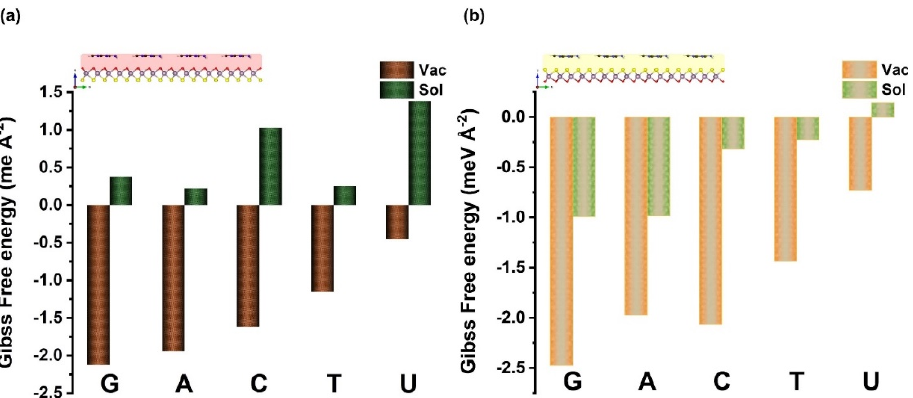
Figure 3. Gibbs free energy (T = 298 K) at vacuum (solvent) of the nucleobases molecules on the Janus MoOS monolayer facets, ( a ) on O layer, ( b ) on S layer, respectively. To understand the effect of the adsorption and sensing process, the Kohn–Shan Table 2. The deformation energy of DNA (RNA) molecules on the Janus MoOS of both oxygen (Oxy.) and sulfur (Sul.) layers, deformation energy of total system E Def–Tot , monolayer surface facets E Def–Lyr , nucleobases molecule E Def–Mol , and covalently energy E Def–Cov (All in eV), respectively. Ads. State